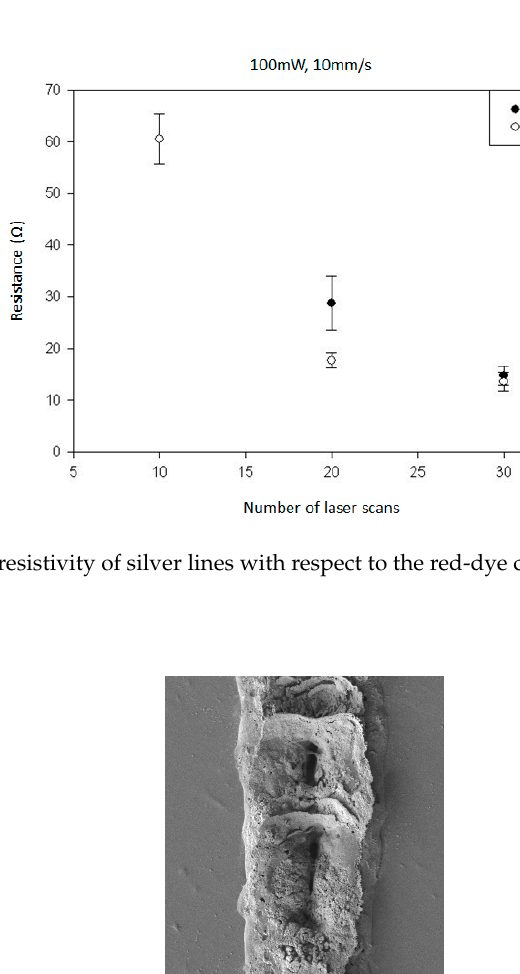
Figure 3. Silver lines fabricated by the LDSP process on the polyethylene terephthalate (PET) substrate with different numbers of laser scans: 10×, 20×, 30× and red-dye concentrations in the process solution of 4 mM, 8 mM, and 16 mM.